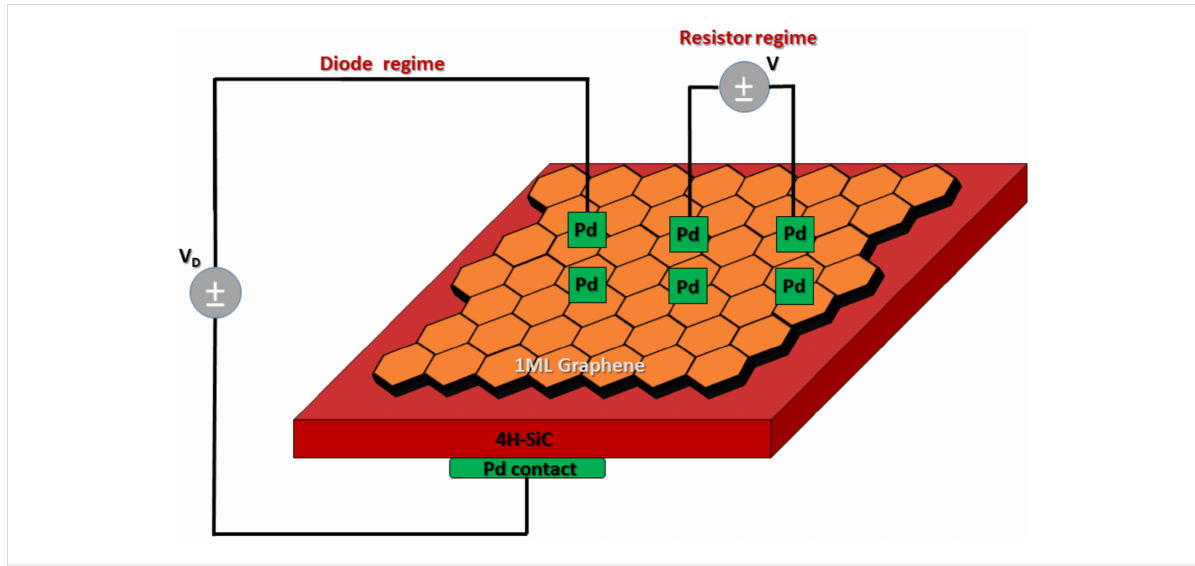
Figure 1: Sketch of the graphene/4H-SiC vertical